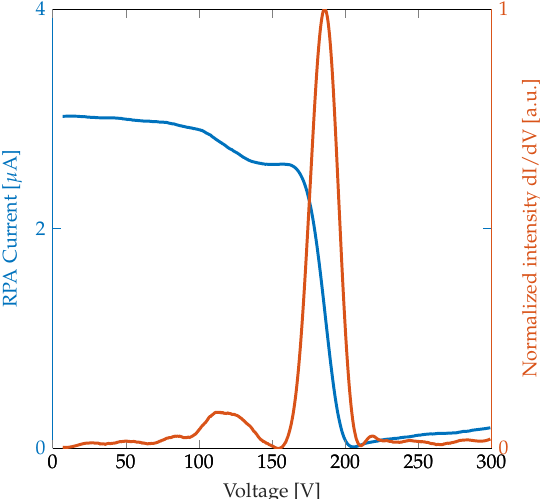
Figure 6. I–V characteristics (in blue) measured with the 4-grid RPA and the corresponding IEDF (in red) ( U d = 200 V, ˙ m a = 5 sccm, θ = 0 ◦